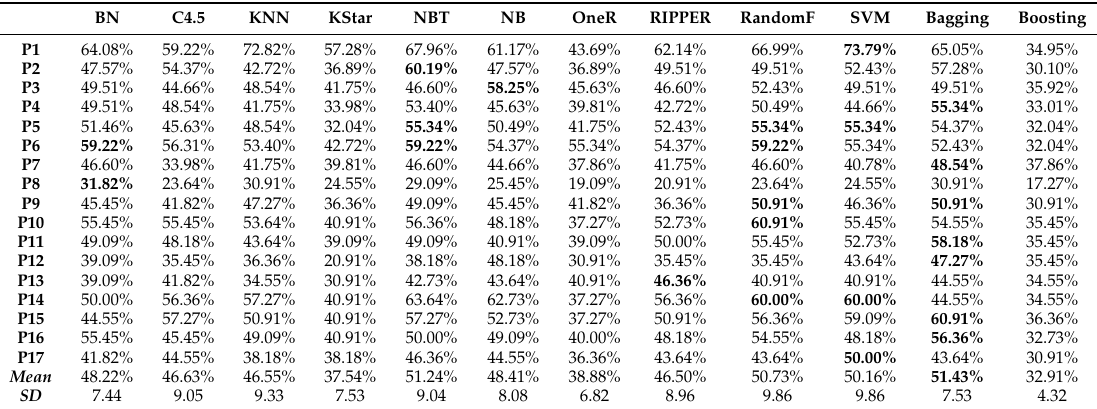
Table 3. First phase. Accuracy percentages for each person using stacking and bagging and boosting multi-classifiers. Mean and SD rows denote the average and standard deviation for each standard multi-classifier considering all of the